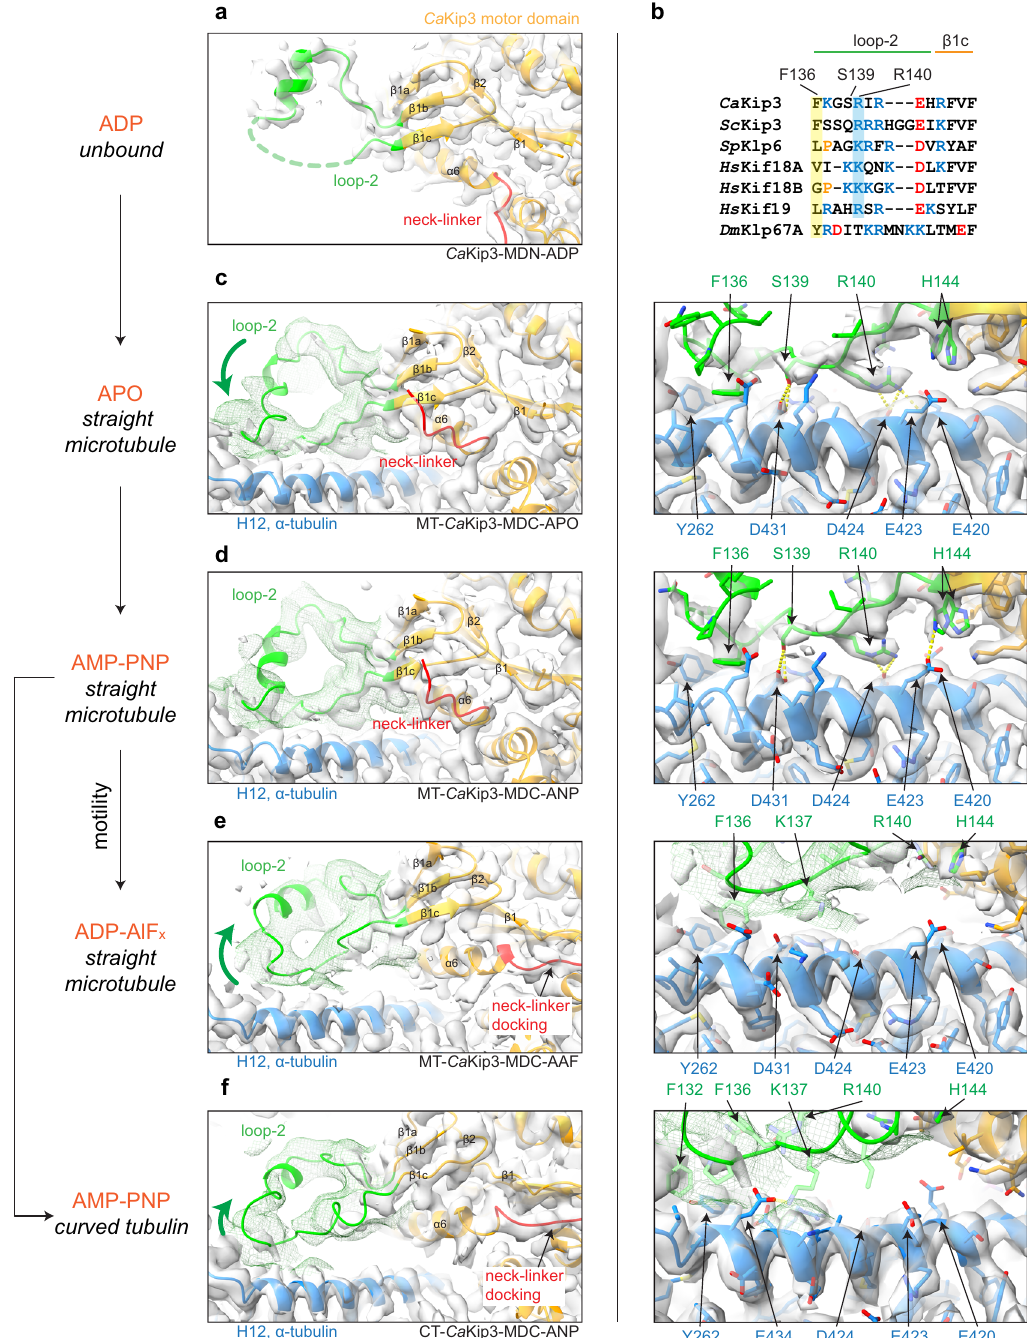
Fig. 3 Loop-2 electron and cryo-EM densities and tubulin contacts. a 2mF obs – dF calc electron density map (contoured at 1.0 σ ) and cartoon model of loop- 2 and the motor domain of the Ca Kip3-MDN crystal structure. b Sequence alignment of the tubulin contact region of Ca Kip3 ’ s loop-2 with other kinesin-8s. Conserved tubulin-bonding residues are highlighted. Cryo-EM map and cartoon model of loop-2 of the c MT- Ca Kip3-MDC-APO complex, d MT- Ca Kip3- MDC-ANP complex, e MT- Ca Kip3-MDC-AAF complex, and f CT- Ca Kip3-MDC-ANP complex. Right panels show close-up view of loop-2-tubulin interactions for each complex. Green mesh maps were low-pass fi ltered at 7 Å (MT- Ca Kip3-MDC-AAF at 9 Å) to better display the noisier density of loop- 2. Interacting residues are shown in stick representation. Pseudo-bonds between interacting atoms were determined and displayed using the “ fi nd clashes and contacts ” routine in UCSF ChimeraX and are represented as yellow dashed